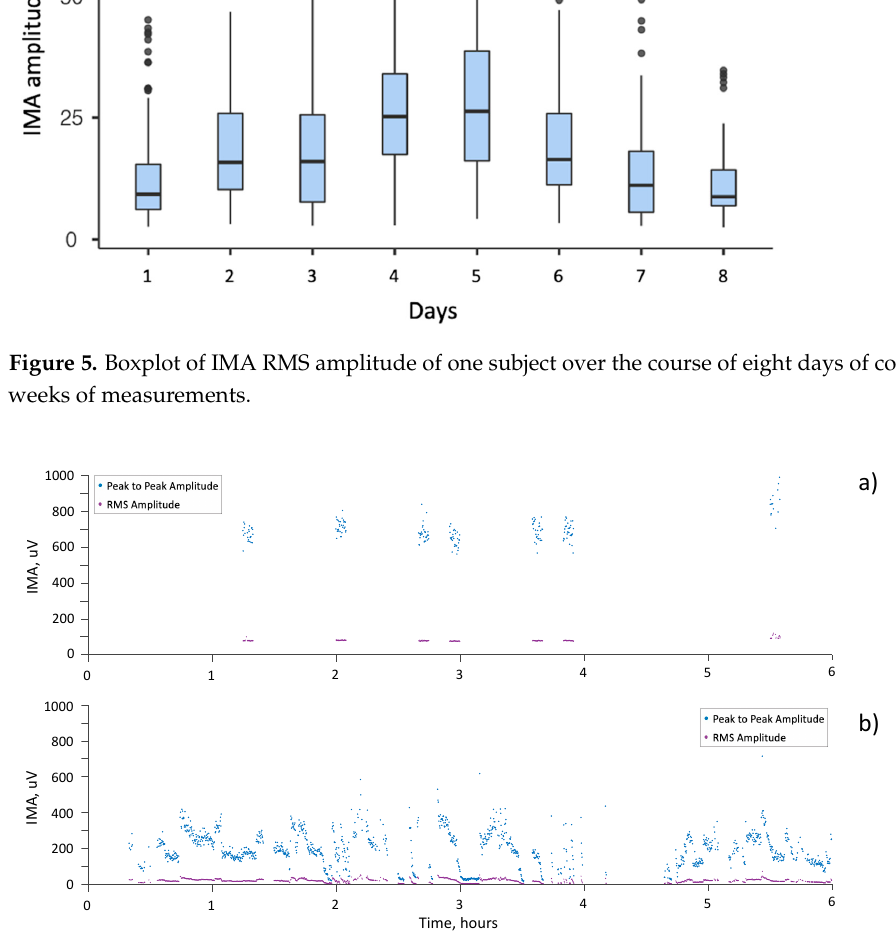
Figure 6. Peak-to-peak (blue dots) and RMS (purple dots) amplitude of IMA during 6 h of recording for ( a ) subject 002-E and ( b ) subject 001-Br.